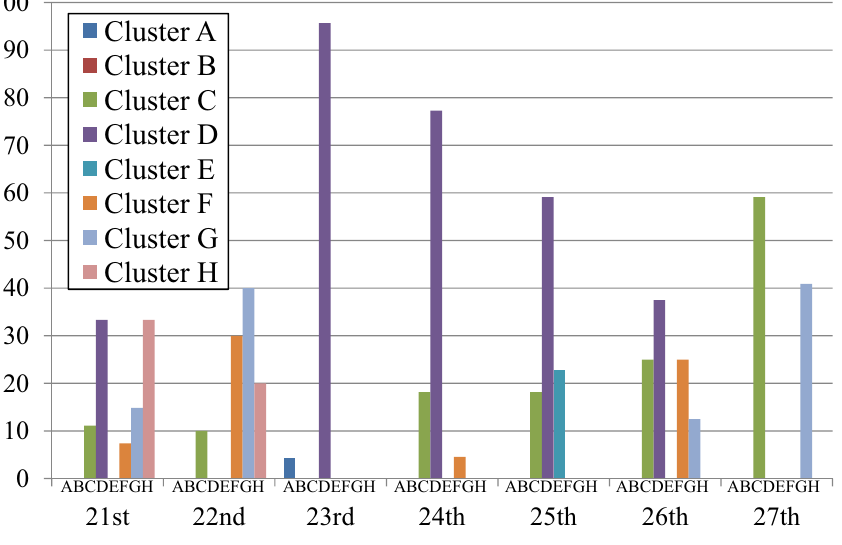
Figure 10. Distribution of temperature after mapping k-means clustering results to the proposed definition of